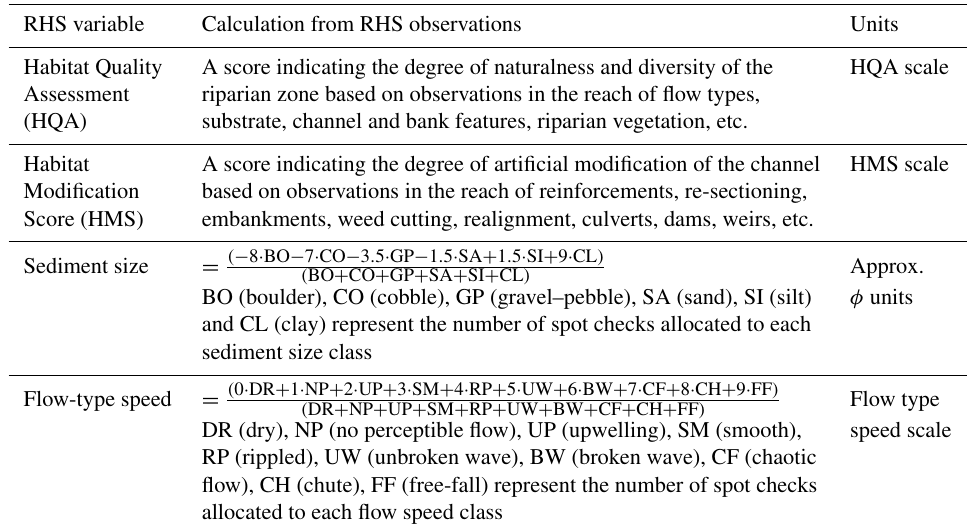
Table 1. RHS variables calculated from RHS observations. RHS variable A score indicating the degree of naturalness and diversity of the HQA scale riparian zone based on observations in the reach of flow types, substrate, channel and bank features, riparian vegetation, etc. A score indicating the degree of artificial modification of the channel HMS scale Modification based on observations in the reach of reinforcements, re-sectioning, embankments, weed cutting, realignment, culverts, dams, weirs,